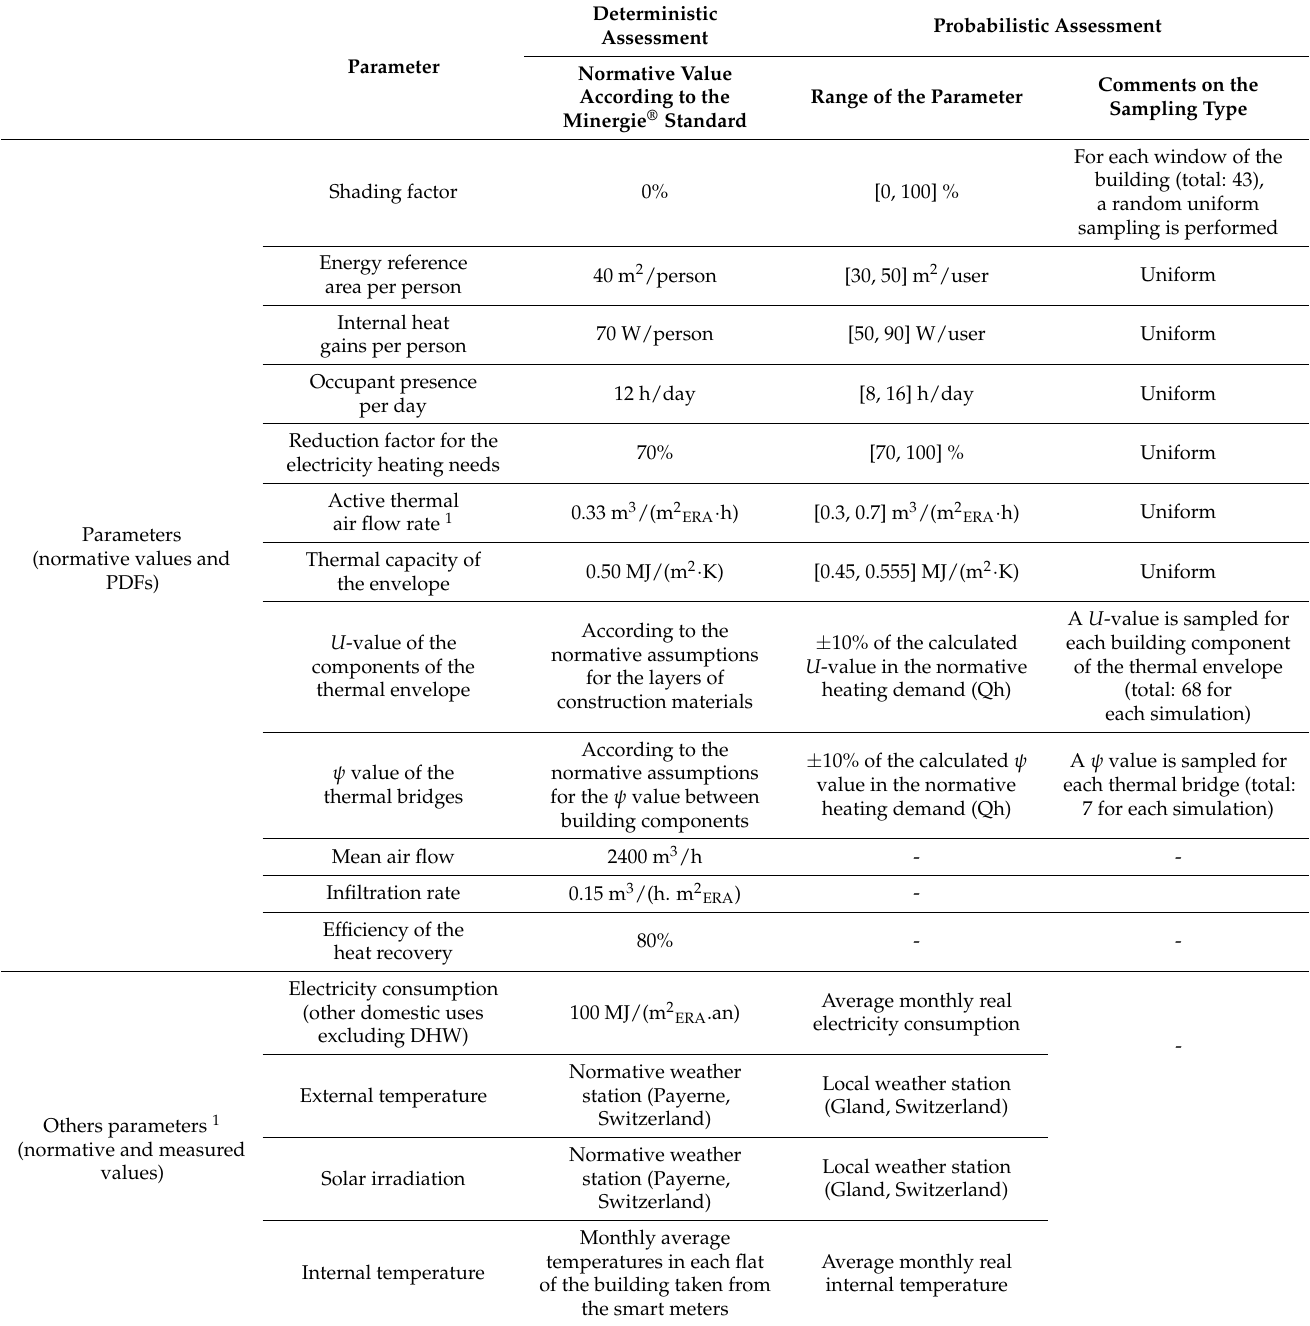
Table 1. Normative value and range considered in both deterministic and stochastic assessment of the building heating